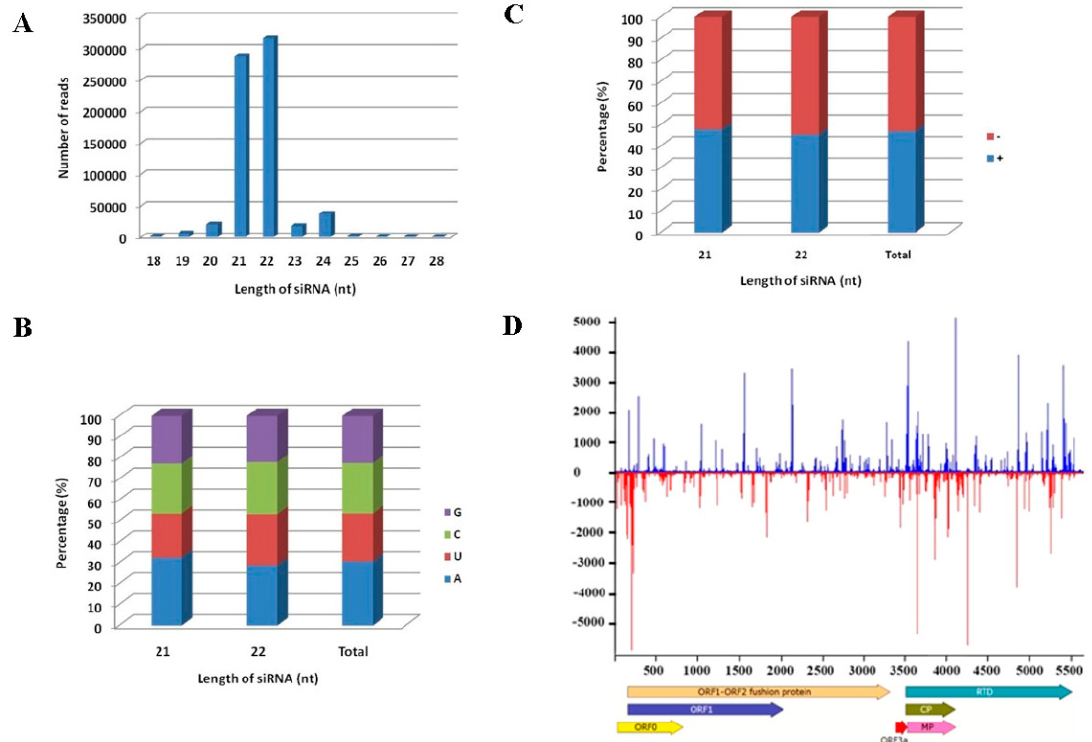
Figure 4. Characterization of the MaYMV vsiRNAs. ( A ) Size distribution of the vsiRNAs along MaYMV genome; ( B ) the relative frequency of the four different 5 ′ terminal nucleotides in vsiRNAs; ( C ) polarity distribution of vsiRNAs that perfectly matched either plus or minus MaYMV genomic sequence; and ( D ) distribution profile of the vsiRNAs that revealed multiple hotspots along the MaYMV genome.